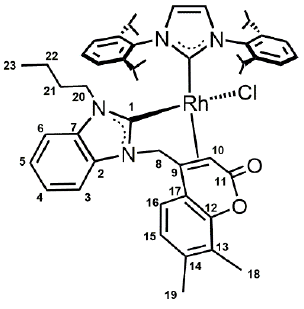
Figure 6. Numbering of atoms for complex 7 .